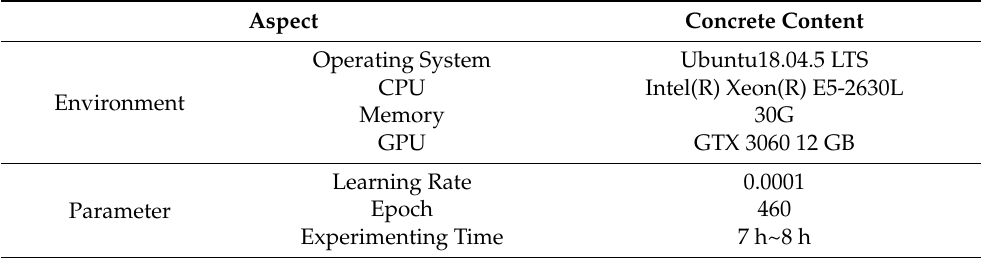
Table 2. Operating environment and some parameter settings.